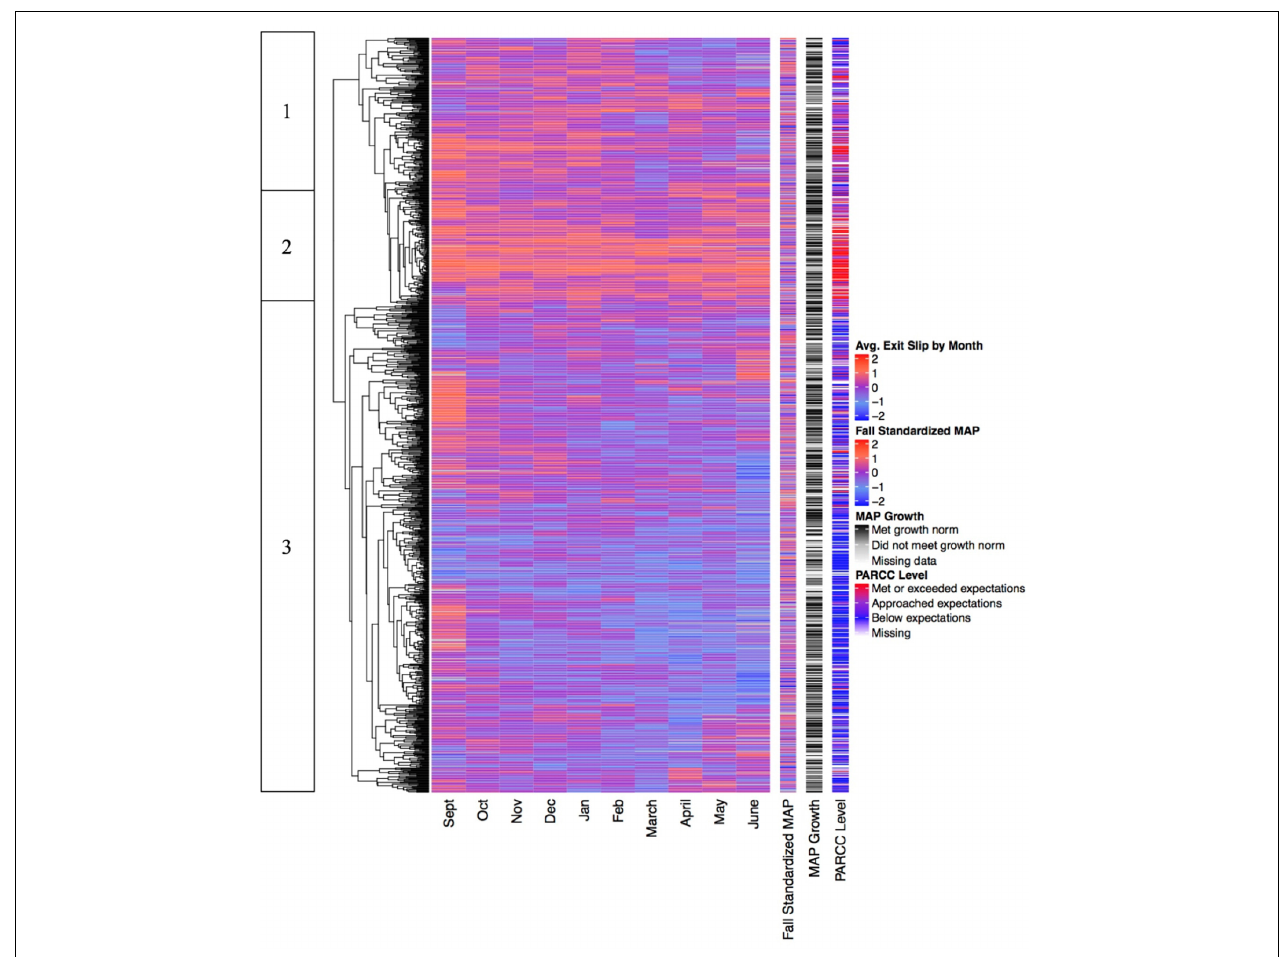
FIGURE 6 | Standardized exit slip scores displayed longitudinally with monthly